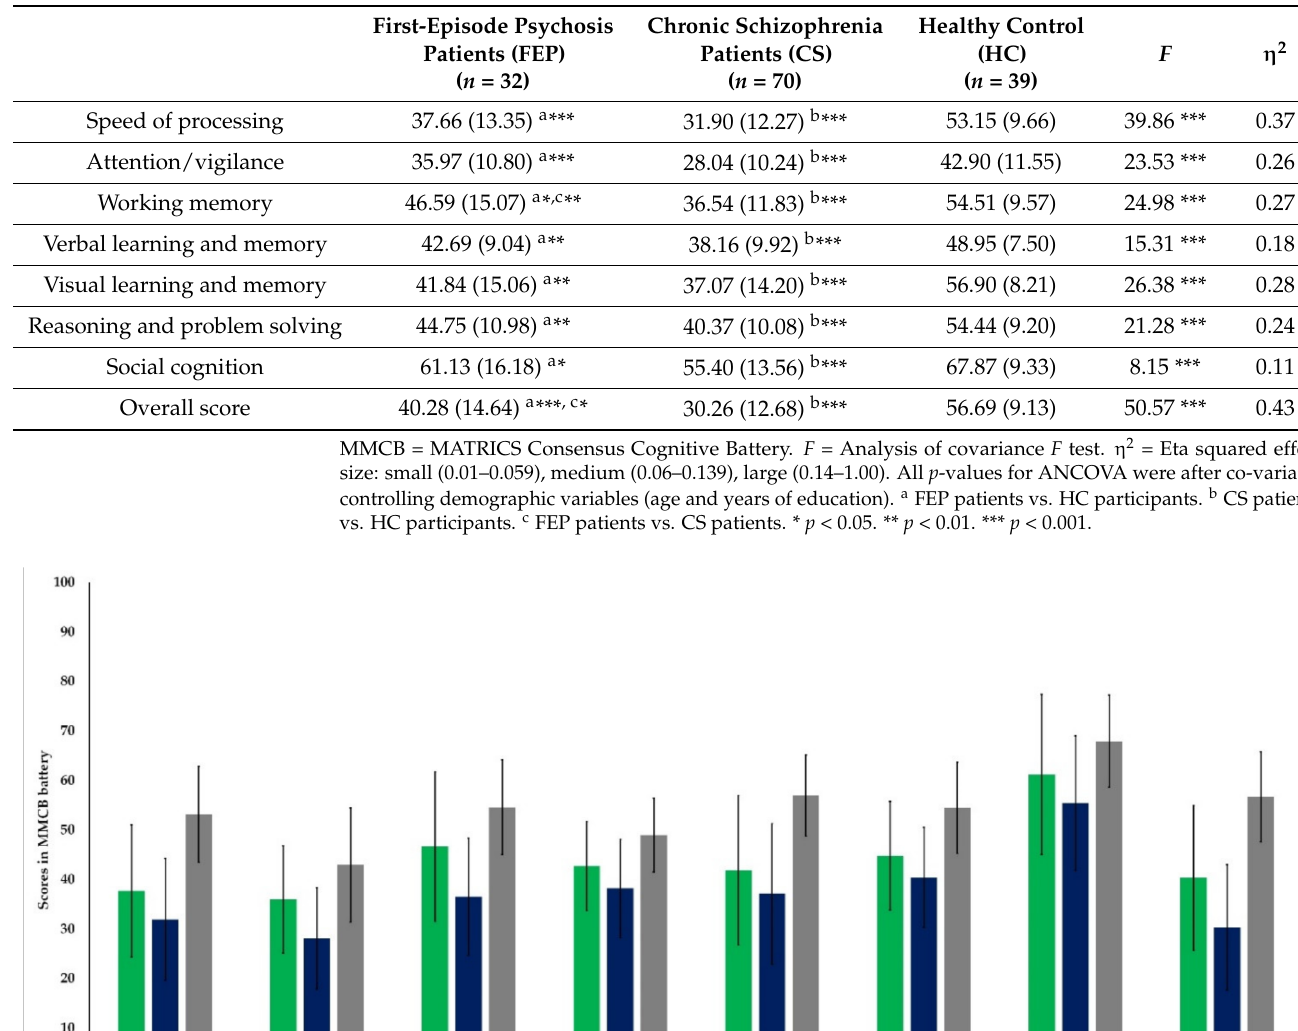
Table 3. Comparison of cognitive domains measured by MMCB battery between participants from three groups.